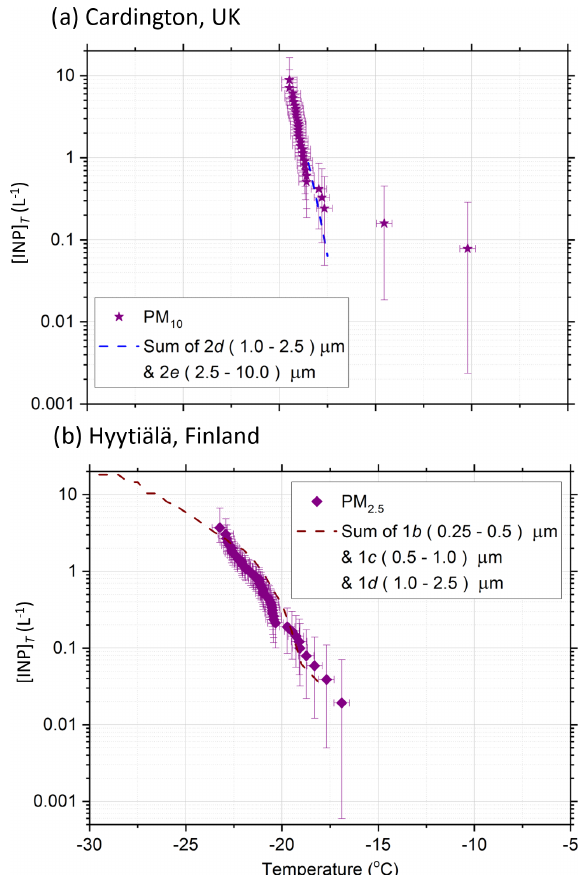
Figure 6. The sum of INP concentrations, [INP] T , for labelled stages measured at (a) Cardington (UK) and (b) Hyytiälä (Fin- land) alongside data from a standard sampler. Cardington data were taken from Impactor 2 whilst on a tethered balloon at 20m above ground level and are shown against a PM 10 sampler at ground level. Hyytiälä data were collected using Impactor 1 at ground level, alongside a PM 2 . 5 sampler. The dotted lines indicate the sum of the INP concentrations for the SHARK impactor stages, calculated by weighting f ice (T ) to the volume of sampled air and summing the concentrations in each temperature